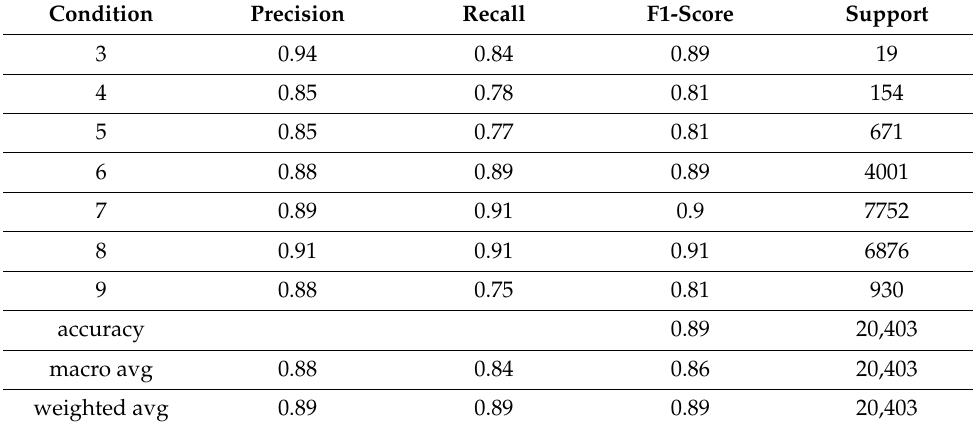
Table 8. Test accuracy of the substructure